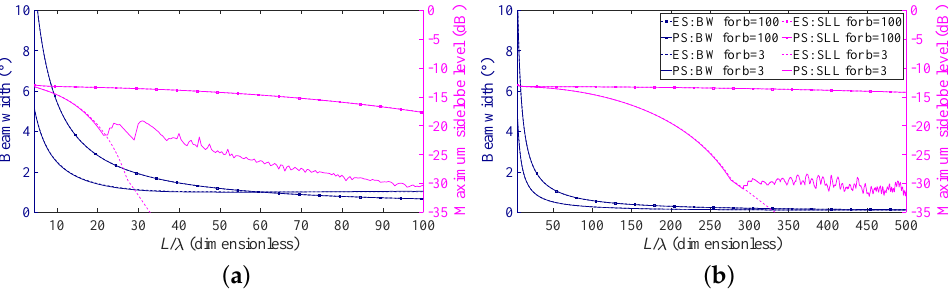
Figure 3. Beamwidth (BW) and sidelobe levels (SLL) as a function of the array aperture. Solid lines refer to PS, dashed lines refer to ES, lines with markers refer to the case b = 100, and lines without markers refer to the case b = 3: ( a ) desired BW = 1 ◦ and ( b ) desired BW = 0.1 ◦